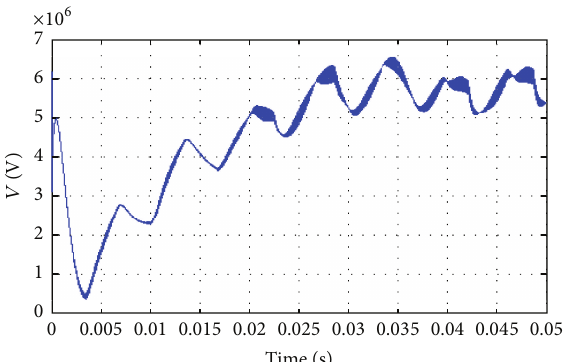
Figure 17: Derating current output.